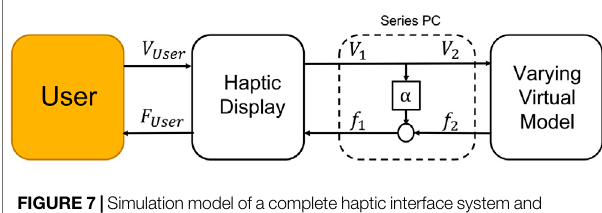
FIGURE 7 | Simulation model of a complete haptic interface system and passivity controller, as implemented here. [Reproduced from Hannaford and Ryu (2002), Figure 8 — permission not obtained for review manuscript ]. System blocks are (left to right): user, haptic display, passivity controller α , and virtual